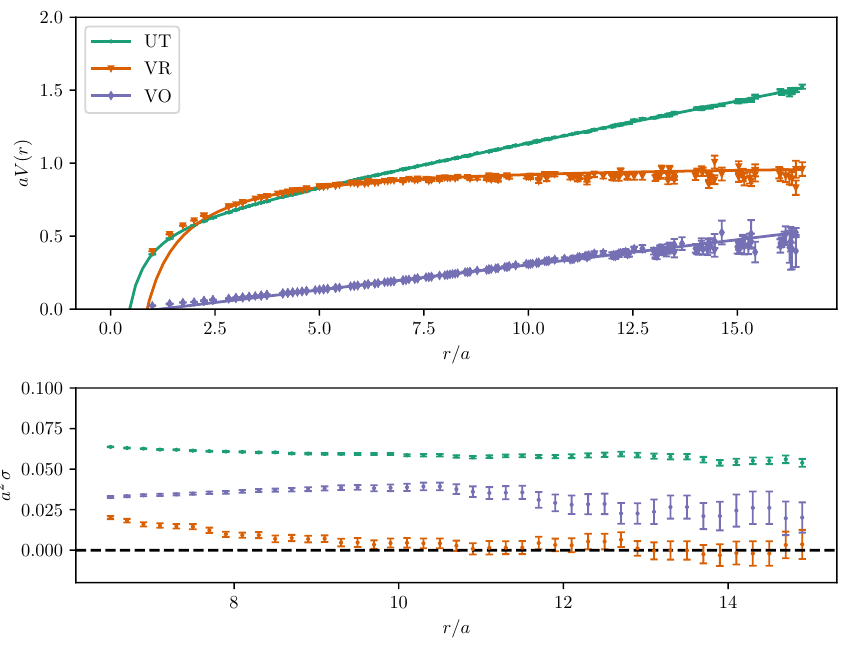
Figure 6: The static quark potential as calculated on the original untouched and vortex-modified pure-gauge ensembles. The lower plot shows the local slope of the potentials at position r obtained from a linear fit with extent r ± 3